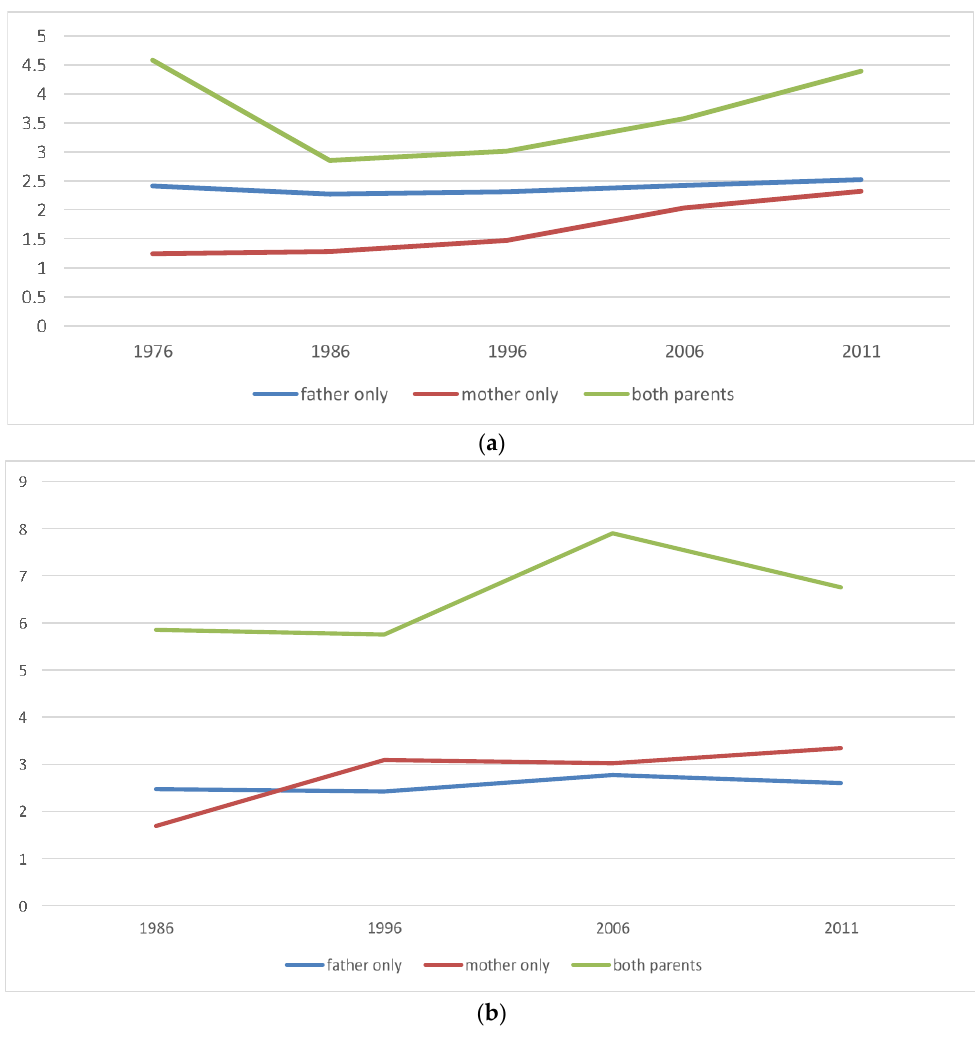
Figure 2. ( a ) Trends in Parent–Son Association for Plans to Enter Engineering: Odds Ratios; ( b ) Parent–Daughter Association for Plans to Enter Engineering: Odds Ratios.